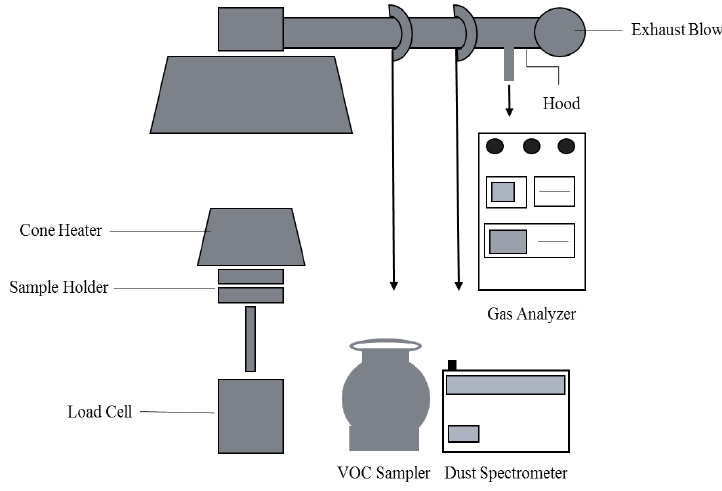
Figure 1. Schematic diagram of the cone calorimeter used in the coal combustion experiment.